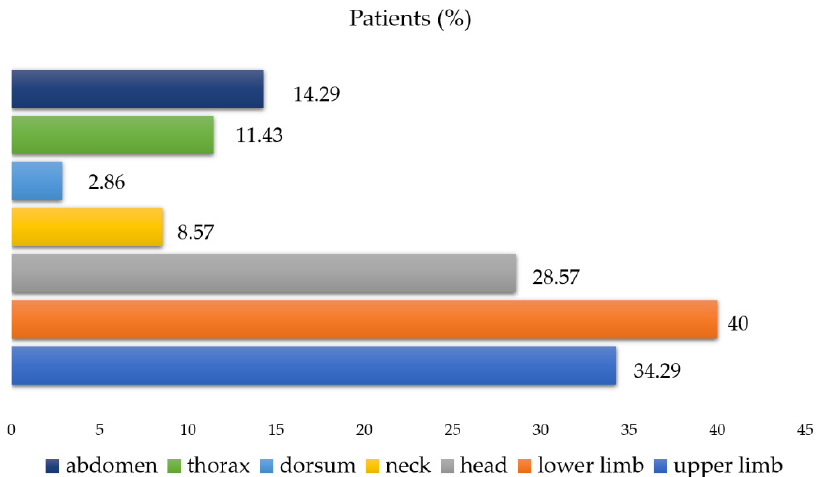
Figure 1. Percentage of patients related to bite location in cases of severe local reactions ( n = 49).